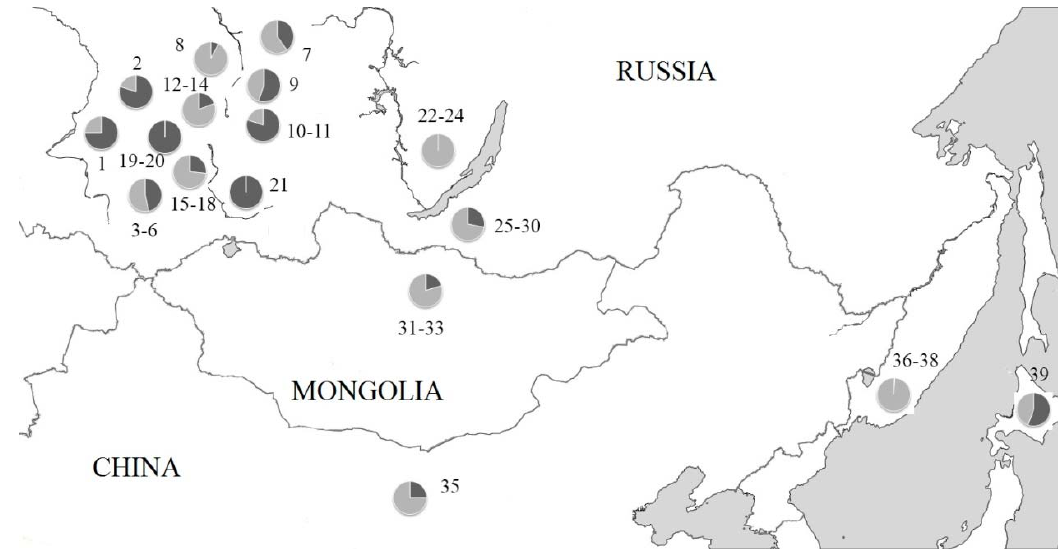
Figure 7. The proportion of animals in A. peninsulae local populations carrying unique B chromosome combinations (dark shading). Arabic numbers beside points are location numbers shown in Table 1. Moreover, combinations with few numbers of Bs (0–4) are more frequent (the absence of B chromosomes was considered as one of 286 variants). The number of chromosomes in a combination negatively correlated with its frequency (Spearman’s rank test, r s = − 0.33, p < 0.05). In other words, the more there are B chromosomes in a karyotype, the less these combinations repeat across the species range and more often become unique. The most repeated was the combination of